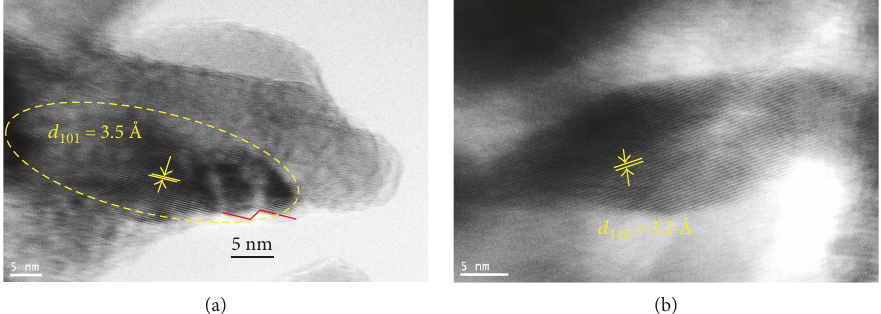
Figure 7: (a) HR-TEM image showing the lattice spacing of anatase TiO shows zigzag-shaped edges of an anatase phase TiO